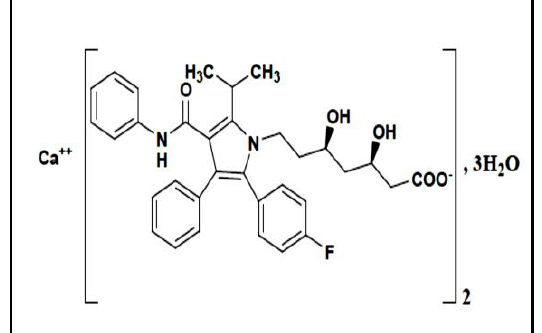
Figure 1. Chemical structure of atorvastatin calcium (3)